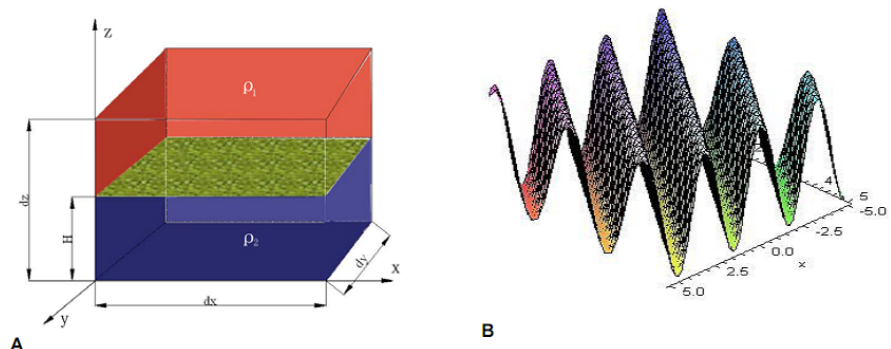
Figure 3. Sinusoidal interface between two fluids: ( A ) control volume at a point in flow; ( B ) potential fluctuation as given in Equation (5).